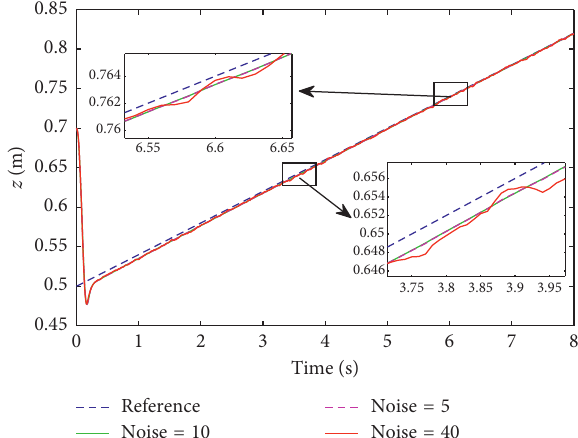
Figure 15: The influence of noise disturbances on